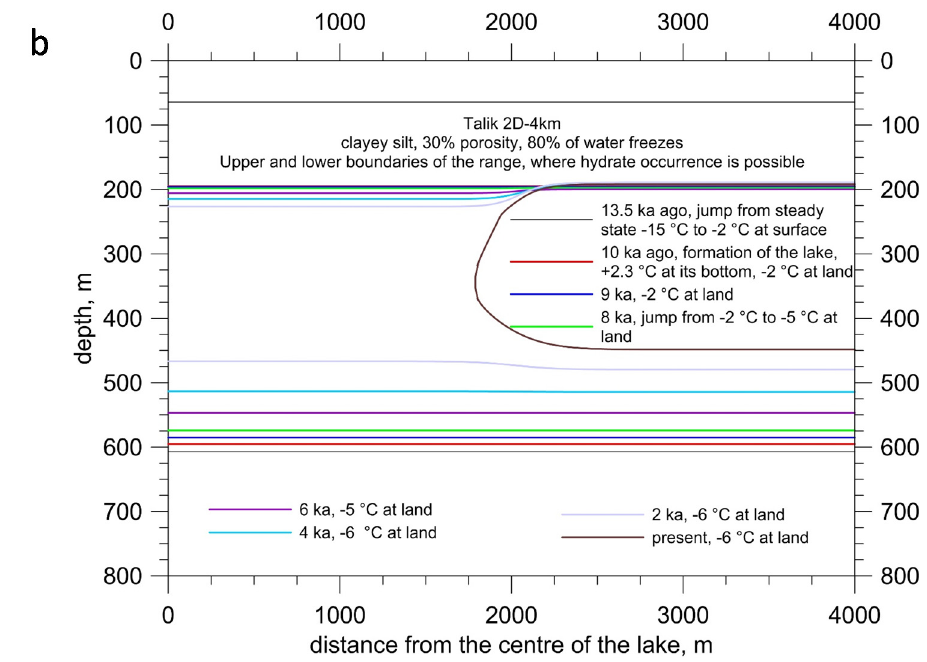
Figure A3. 4 km lake spatial and temporal changes for permafrost ( a ) and GH ( b ) for 13.5 ka ago, 10 ka ago, 9 ka ago, 8 ka ago, 6 ka ago, 4 ka ago, 2 ka and the Present.